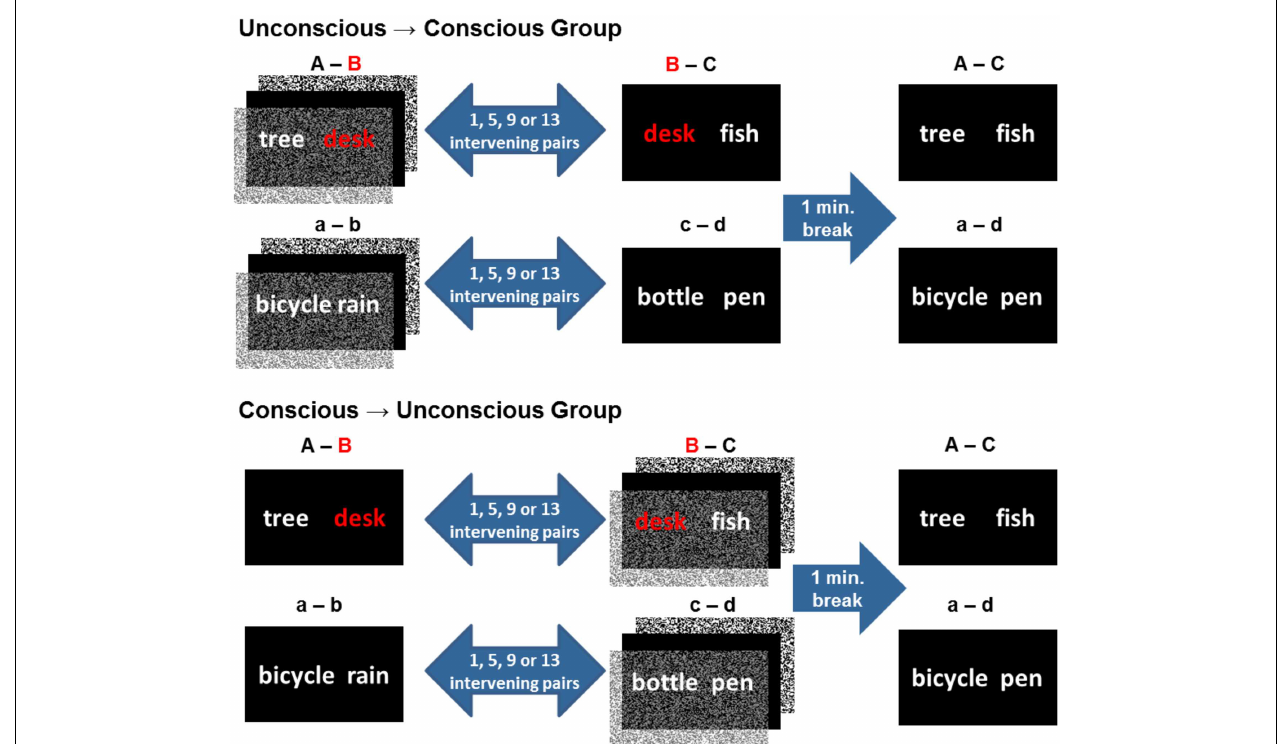
refer to overlapping word pairs presented in the experimental condition as A–B and B–C and to non-overlapping word pairs presented in the control condition as a–b, c–d.Words in test events were presented supraliminal. A and C words from the two encoding events were re-presented at test to induce the retrieval of the common counterpart (B) in the experimental condition. In the control condition, a and d words were re-presented at test, each of which could activate its respective counterpart (b or c), but no common counterpart. Hence retrieval words given in the control condition were not episodically related by a word that was part of both encoding